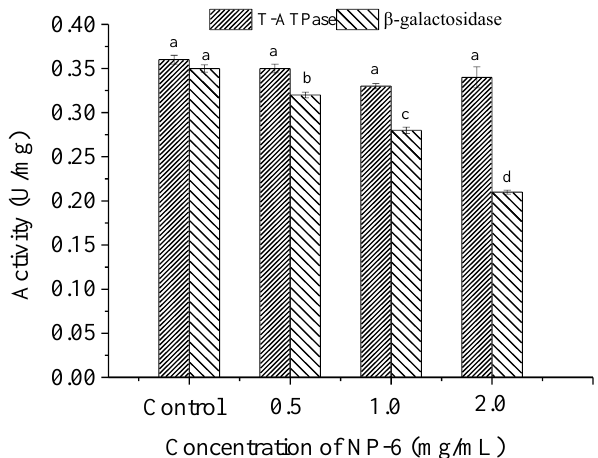
Figure 5. The effect of NP-6 on the activities of bacterial intracellular enzymes. The values represent the means ± SD ( n = 3). Bars with different letters are significantly different ( p < 0.05).